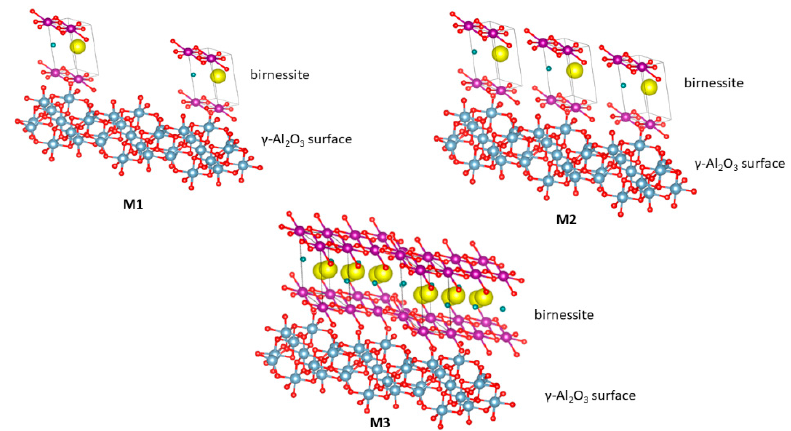
Figure 1. Schematic representation of manganese oxides formed when the content of the manganate ion is increased. M1: 5% by weight of MnO x / Al 2 O 3 , M2: 10% by weight of MnO x / Al 2 O 3 and M3: 20% by weight of MnO x / Al 2 O 3 . The red circles represent oxygen atoms; the yellow circles represent the K + cations; the violet circle represents the manganese ions; the green circles represent the water molecules; and the blue circles represent Al 3+ ions.